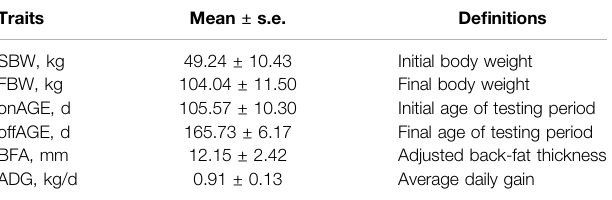
TABLE 1 | Mean and standard deviation of each traits.